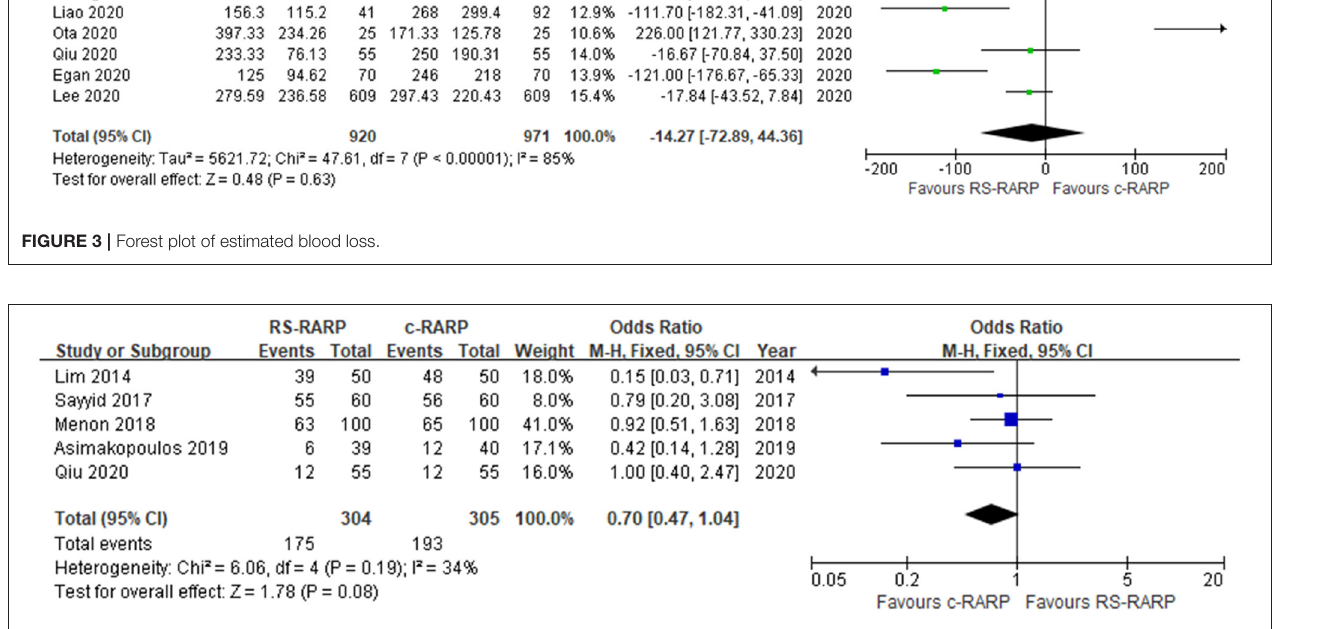
FIGURE 4 | Forest plot of pelvic lymph node dissection